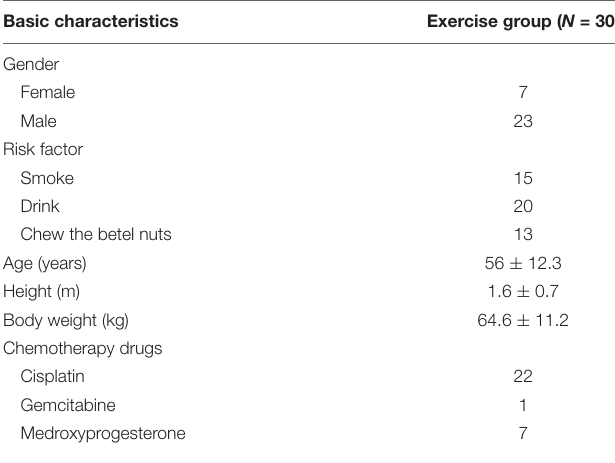
TABLE 1 | Basic characteristics of